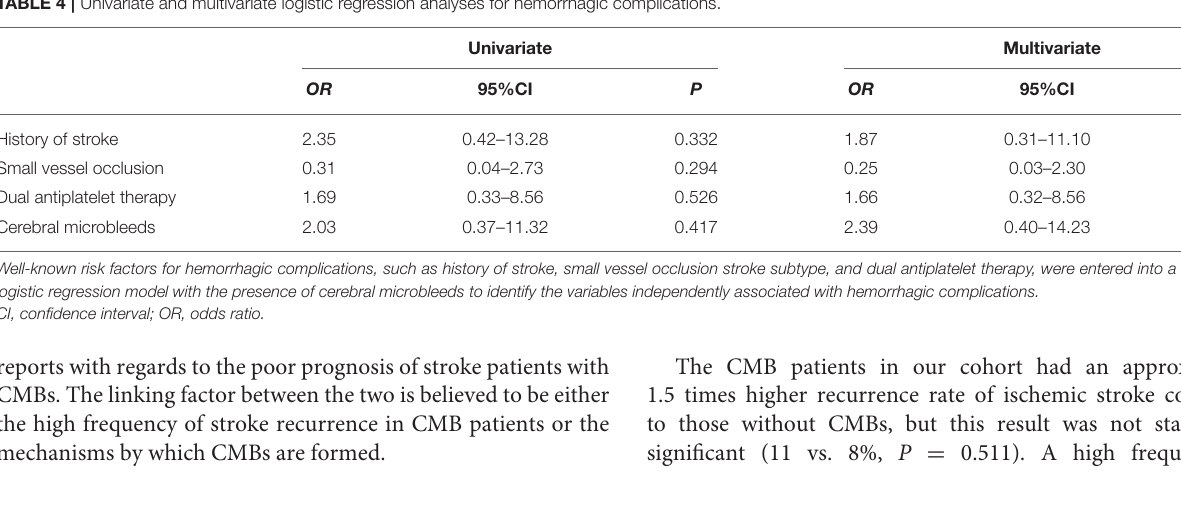
TABLE 3 | Univariate and multivariate logistic regression analyses for ischemic stroke recurrence. Univariate Multivariate OR 95%CI P OR 95%CI P Age 1.01 0.98–1.05 0.579 0.99 0.96–1.03 0.762 History of diabetes mellitus 1.50